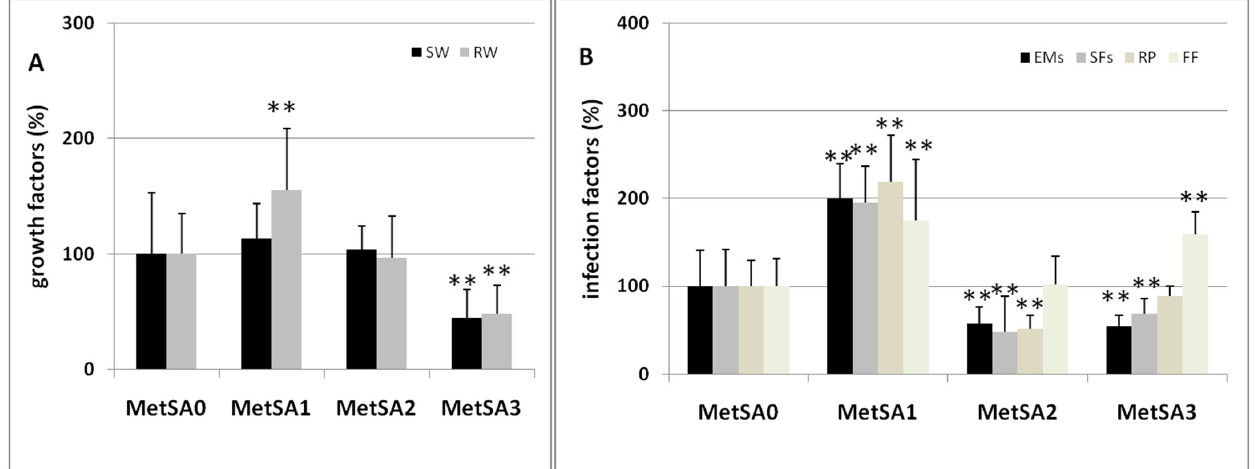
Figure 4. Effects of sprayed MetSA on plant growth ( A ) and nematode infection ( B ) in tomato plants 40 days after M. incognita inoculation. Growth factors were shoot (SW) and root (RW) weights. Infection was evaluated by the numbers of egg masses (EMs) per root system, the numbers of sedentary forms (SFs) per root system, reproduction potential (RP), and female fecundity (FF). Values for MetSA-treated plants are expressed in percentages with respect to untreated plants (set at 100%—SA0). Values ± standard deviations of controls were statistically differentiated from those of treatments by a paired t -test (** p < 0.01). Ranges of doses are expressed as mg MetSA g − 1 plant fresh weight at treatment: MetSA1 0.4–0.6; MetSA2 2.0–5.0; MetSA3 10.0–20.0. MetSA1 favored, whereas MetSA2 repressed, infection, and MetSA3 was toxic to plants. Surprisingly, MetSA2-mediated infection reduction did not result in higher plant